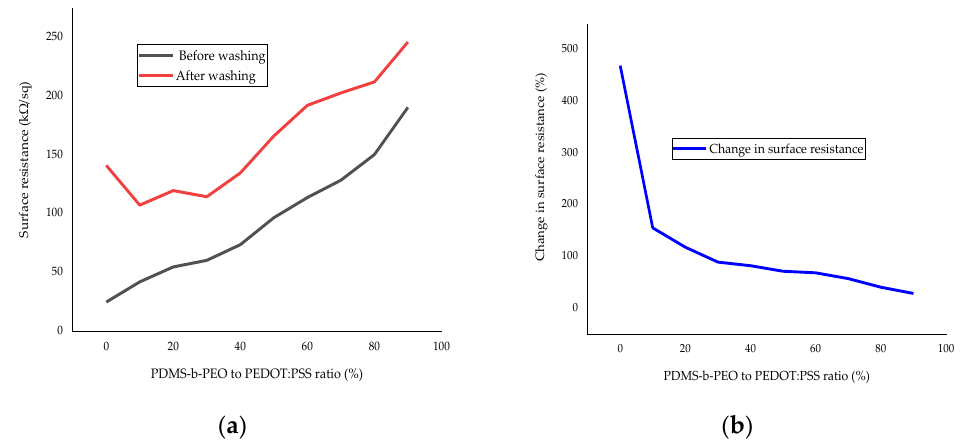
Figure 13. Effect of washing on the surface resistance at different PDMS-b-PEO to PEDOT:PSS ratios: ( a ) Figure 13. E ff ect of washing on the surface resistance at di ff erent PDMS-b-PEO to PEDOT:PSS ratios: ( a )